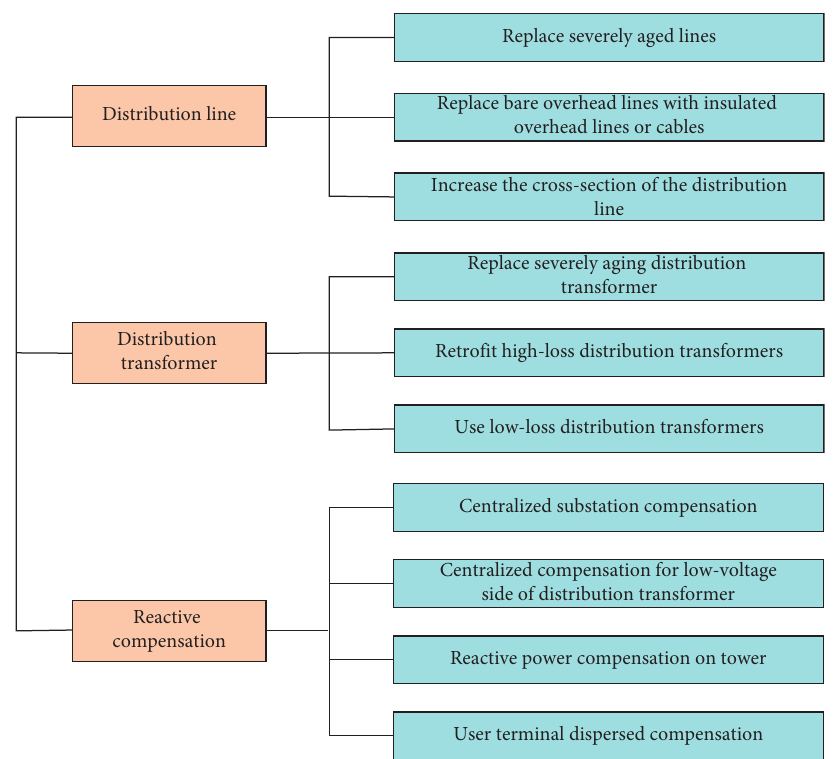
Figure 2: Commonly used energy saving and loss reduction strategies of the distribution network.